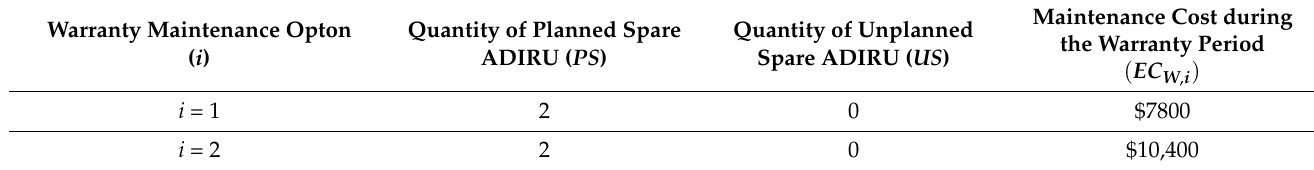
Table 1. The calculated results for the options of warranty maintenance.